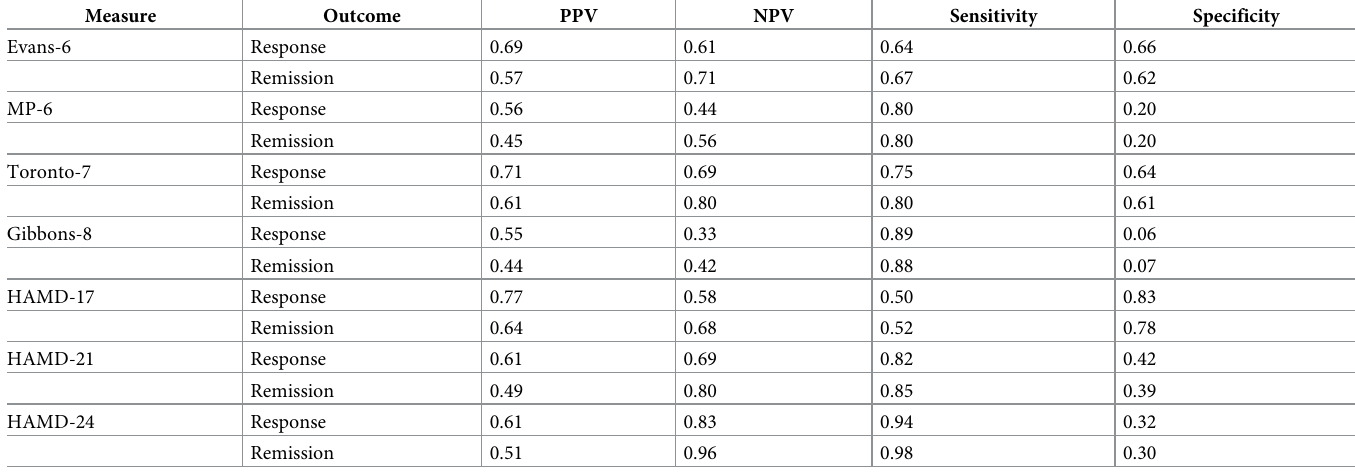
Table 5. Sensitivity, specificity, positive predictive values (PPV) and negative predictive values (NPV) for early improvement on the HAMD subscales and full ver- sions to predict response and remission.